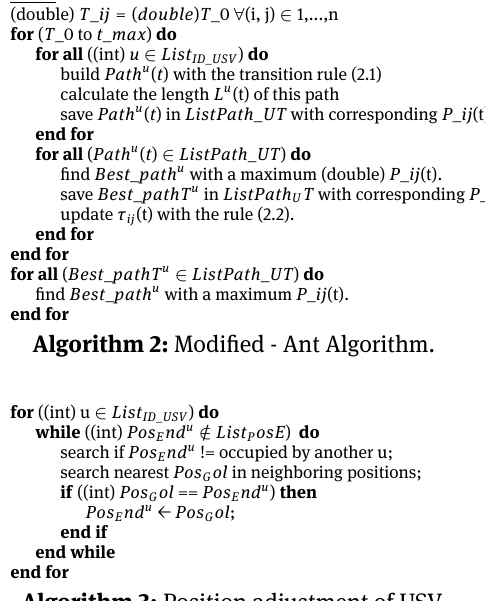
Algorithm 3: Position adjustment of